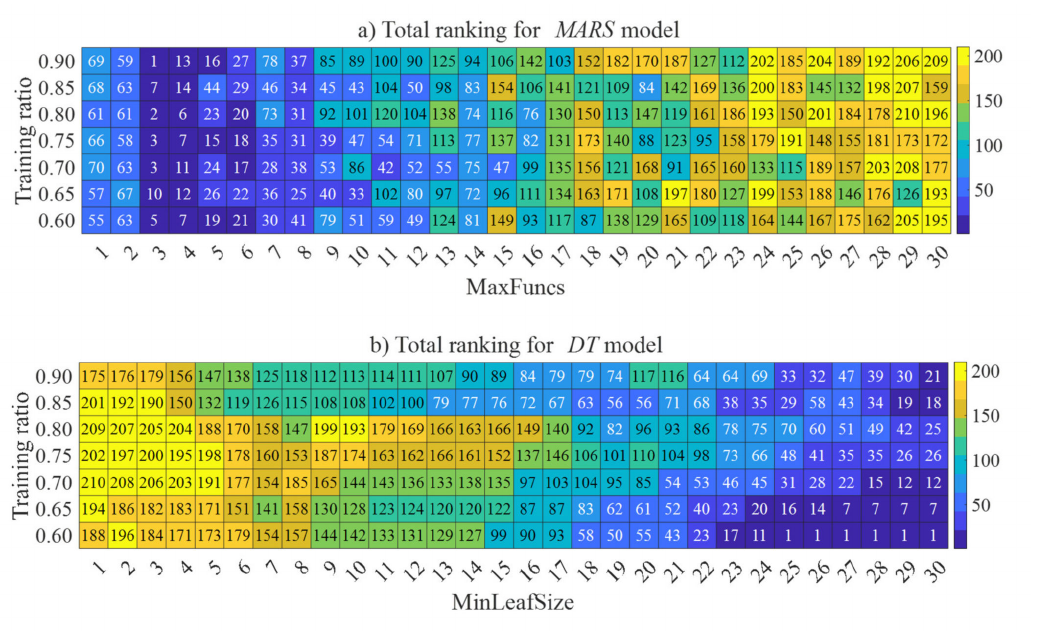
Figure 8. The performance of 210 ANN models.